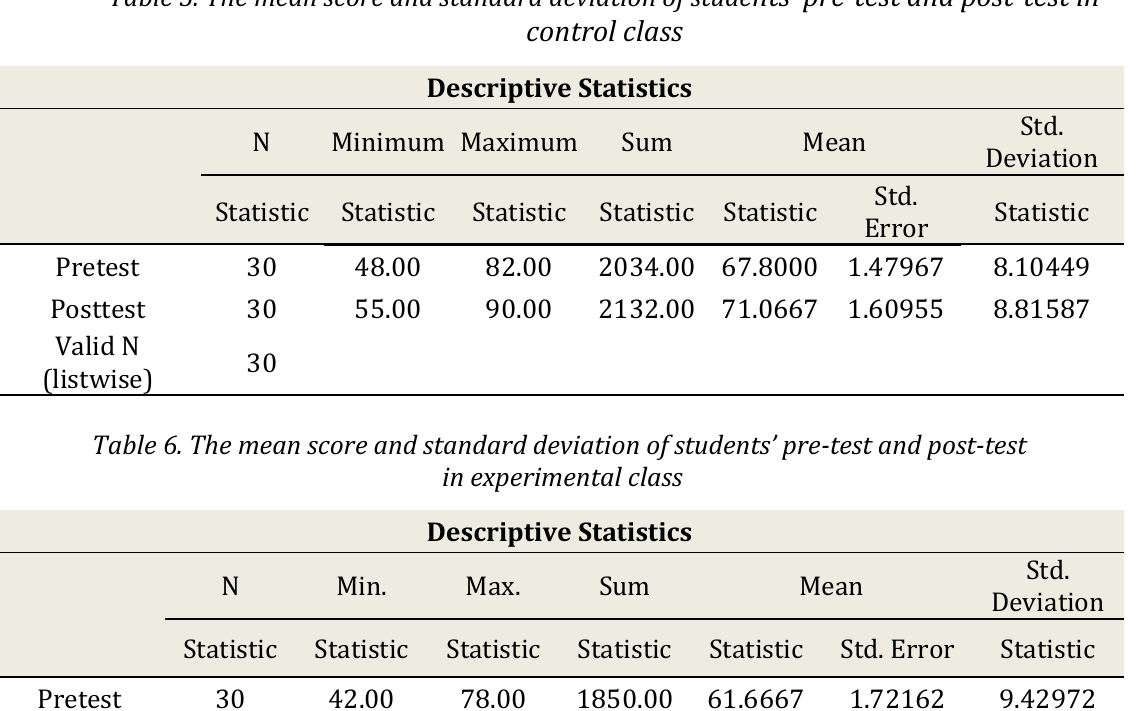
Table 5. The mean score and standard deviation of stude nts’ pre -test and post-test in